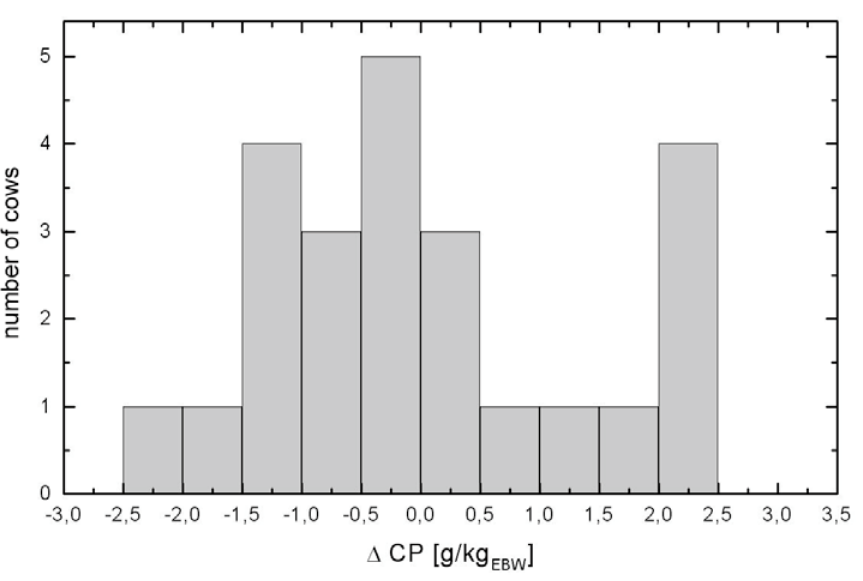
Figure 5 Distribution of differences ΔCP=CP2−CP2 (CP2: protein level at second sampling, CP1: protein level at first sampling) in grams for 1 kg of empty body weight